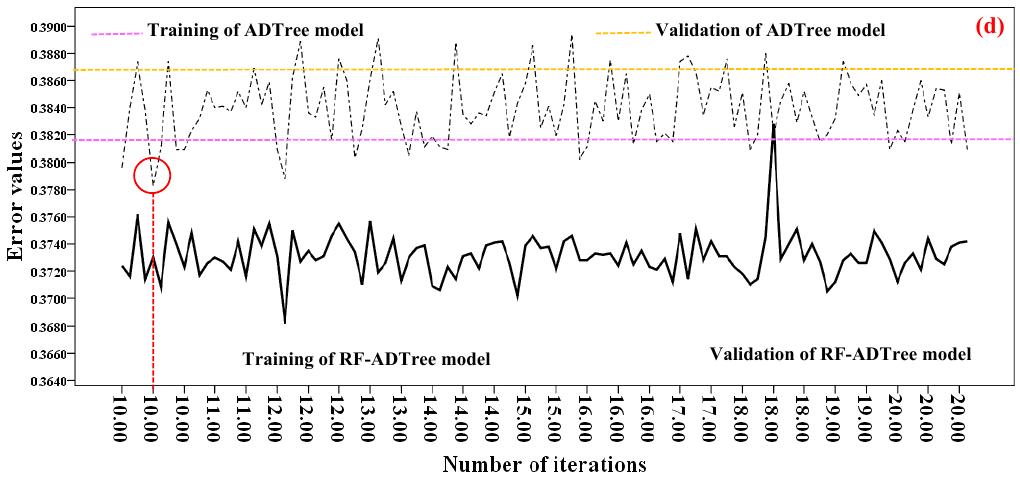
Figure 5. Modeling process for selecting the best values for the number of seed and iteration parameters for rotation forest (RF) as a Meta/ensemble classifier based on alternating decision tree (RF-ADTree) model: ( a ) number of seeds based on the area under the curve (AUC) of Receiver Operating Characteristic (ROC), ( b ) number of iterations based on the AUC of ROC, ( c ) number of seeds based on the root mean square error (RMSE), and ( d ) number of iterations based on the RMSE.